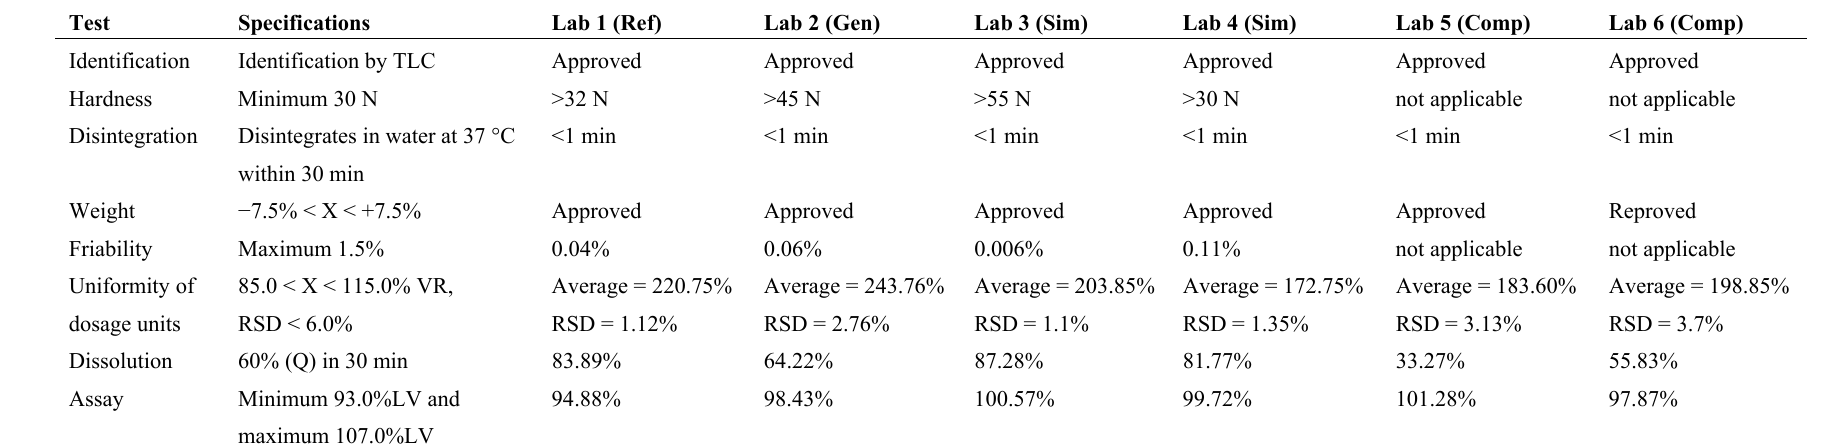
Table 1. Results of quality control of medicines Lab 1, Lab 2, Lab 3, Lab 4, Lab 5 and Lab